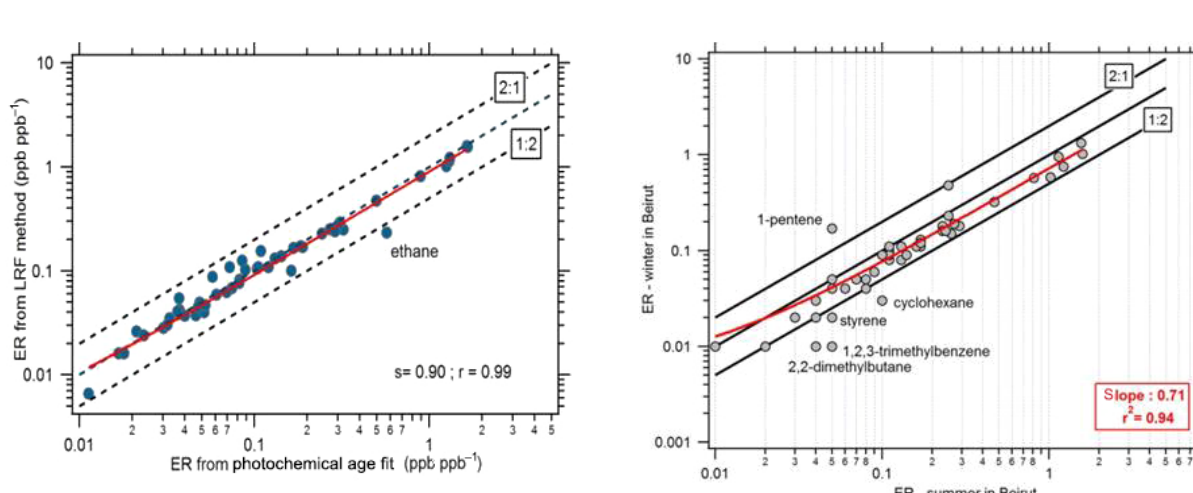
Figure 6. Comparison of summer and winter emission ratios vs. acetylene in